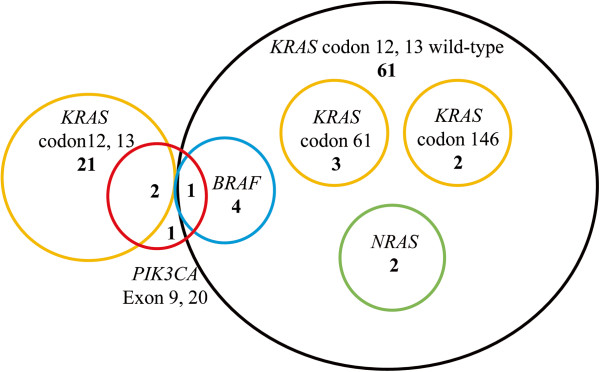
Associations among KRAS, BRAF, NRAS, and PIK3CA mutations. KRAS codon 12 and 13, KRAS codon 61 and 146, BRAF, and NRAS mutations were mutually exclusive. Only PIK3CA Exon 9 and 20 mutations overlapped KRAS codon 12 and 13 and BRAF mutations.